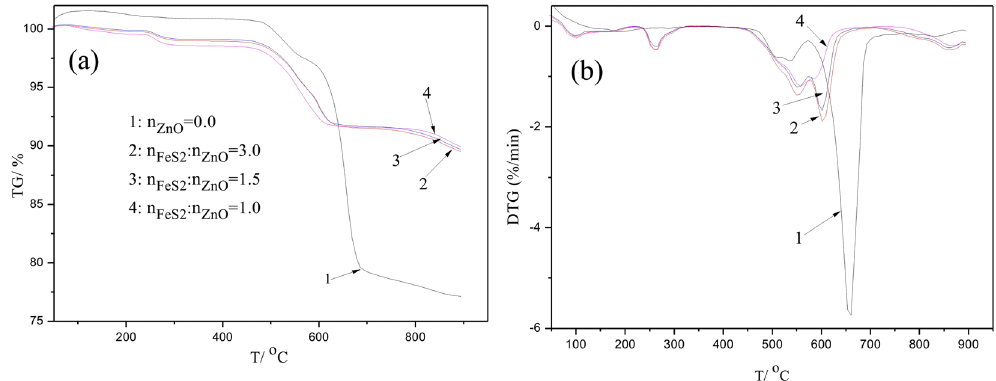
Figure 3. TG and DTG curves of the samples with respect to temperature and different mole ratio of FeS 2 to